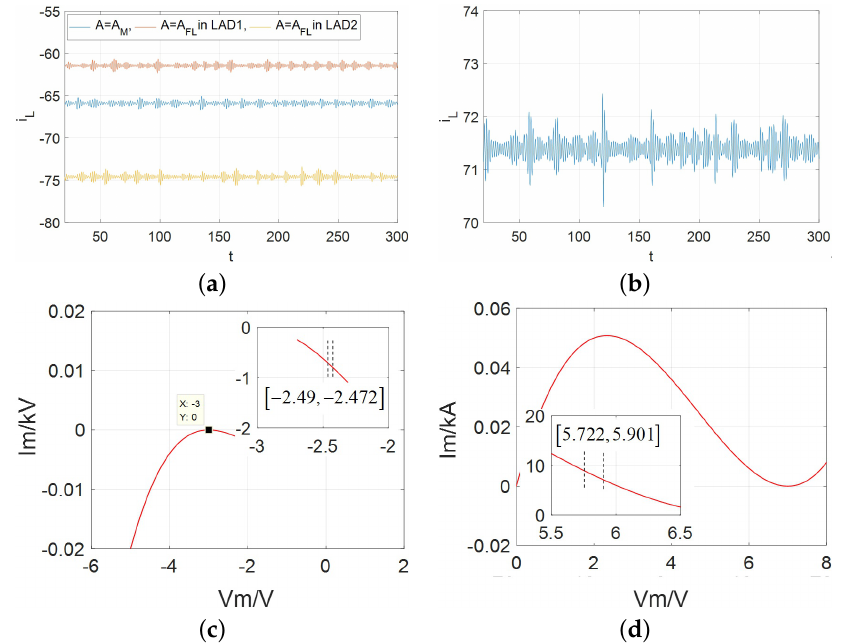
Figure 22. The bursting oscillation behaviors in the LAD for the proposed model: ( a ) at v = − 2.485 V for A = A M over v ∈ [ − 2.49, − 2.472 ] is graphed by blue solid line, at v = − 3.82 V for A = A FL in LAD1 is graphed by green solid line, at v = − 13.241 V for A = A FL in LAD2 is graphed by pink solid line; ( b ) at v = 5.9 V for A = A FL over v ∈ [ 5.722,5.901 ] ; ( c ) The bursting region of A = A M ; ( d ) The bursting region A = A FL